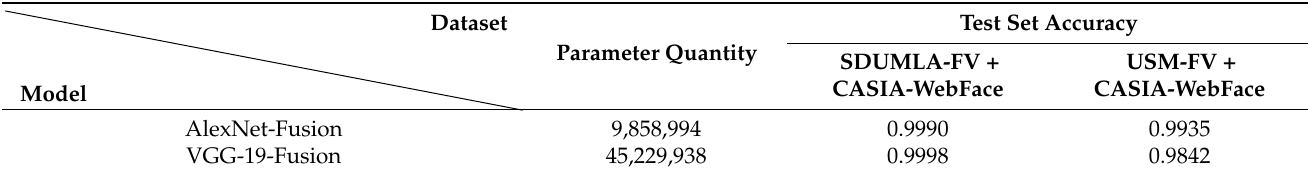
Table 5. Results of multimodal experiments.